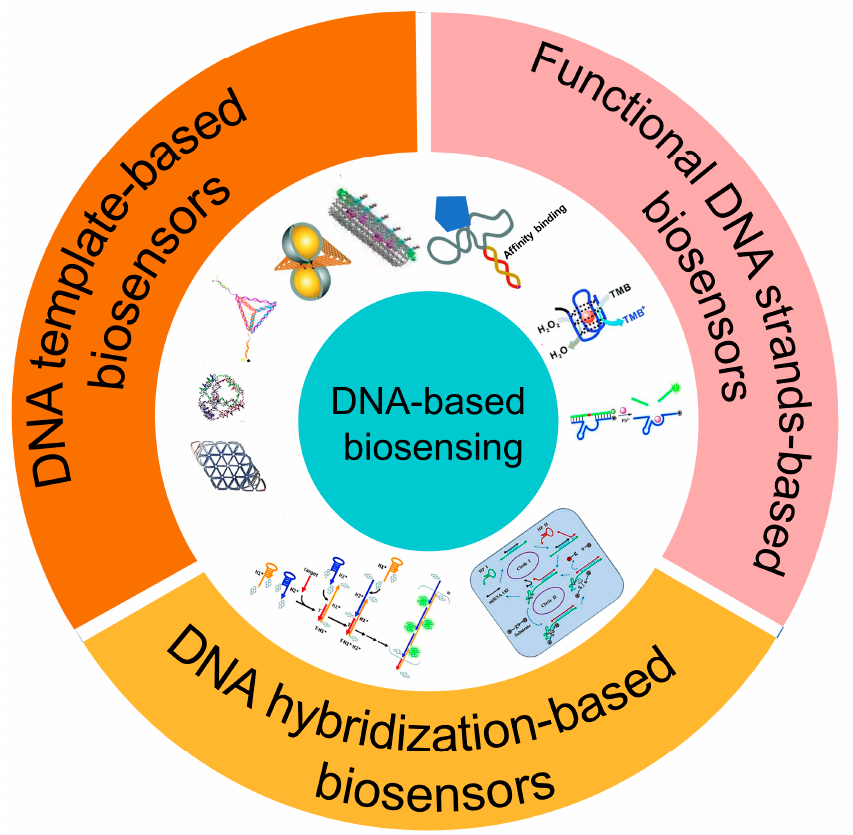
Figure 1. Schematic diagram of different DNA-based Figure 1. S chematic diagram of different DNA-based biosensors.